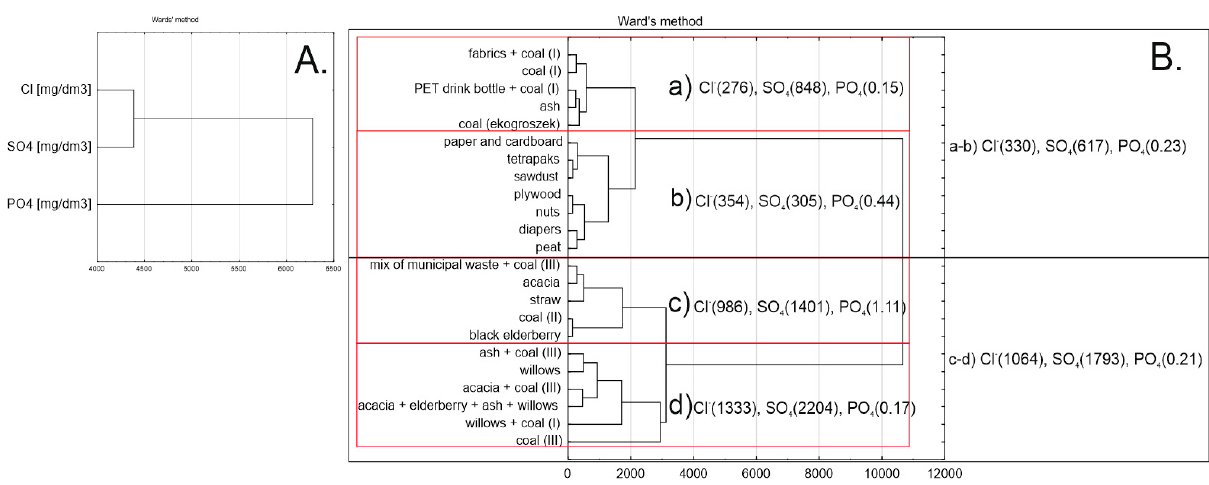
Figure 3. Dendrograms for ashes: ( A )—for all determined anion groups, ( B )—for all tested samples; the numbers in brackets relate to the median concentrations of that cluster.